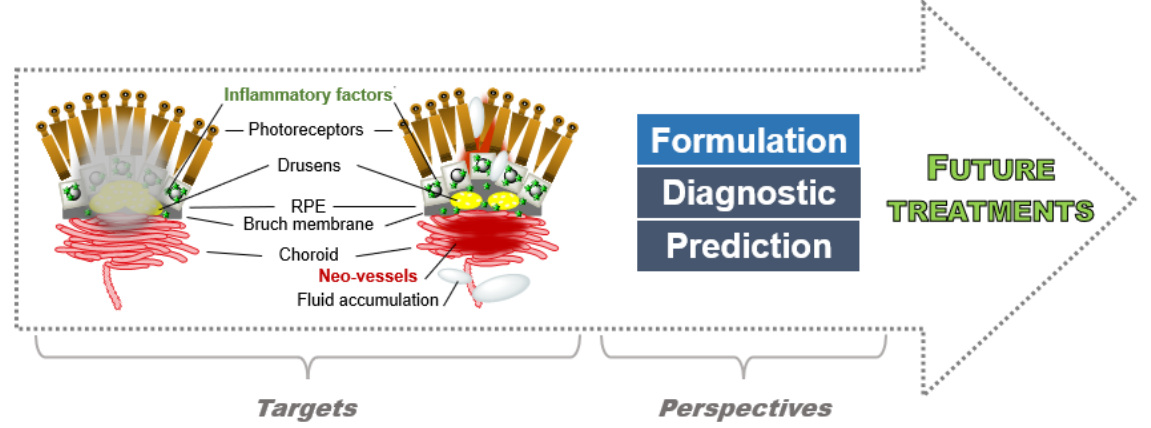
Figure 21. AMD targets and perspectives towards a future treatment.